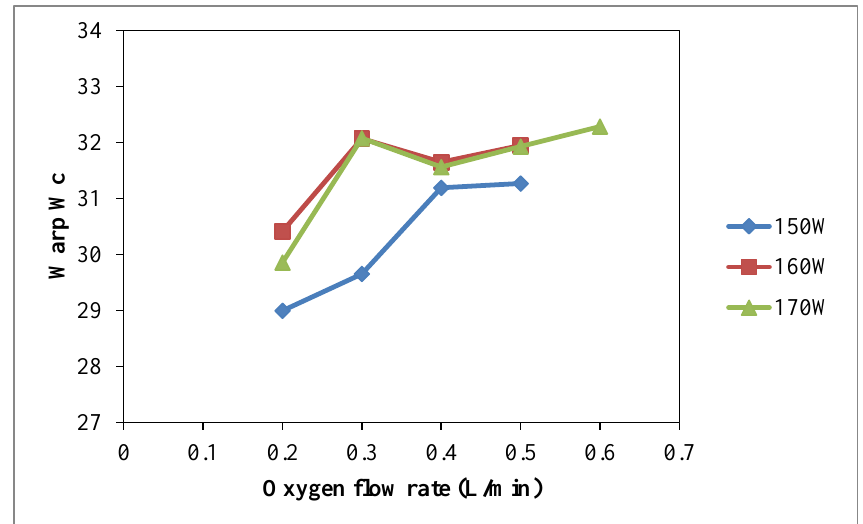
Figure 6. Effect of oxygen flow rate on warp W c (Oxygen flow rate: 0.2 L/min, 0.3 L/min, 0.4 L/min, 0.5 L/min and 0.6 L/min; Discharge power: 150 W, 160 W and 170 W; Jet travelling speed: 5 mm/s and Jet-to-substrate distance: 3 mm).